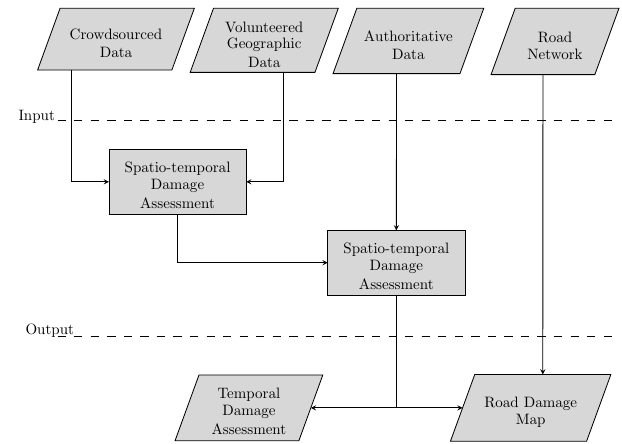
Fig. 2. Flowchart illustrating the methodology for determining road Figure 2: Flowchart illustrating the methodology for determining road damage from non- authoritative data. damage from non-authoritative The model begins with the integration of non-authoritative data (i.e.